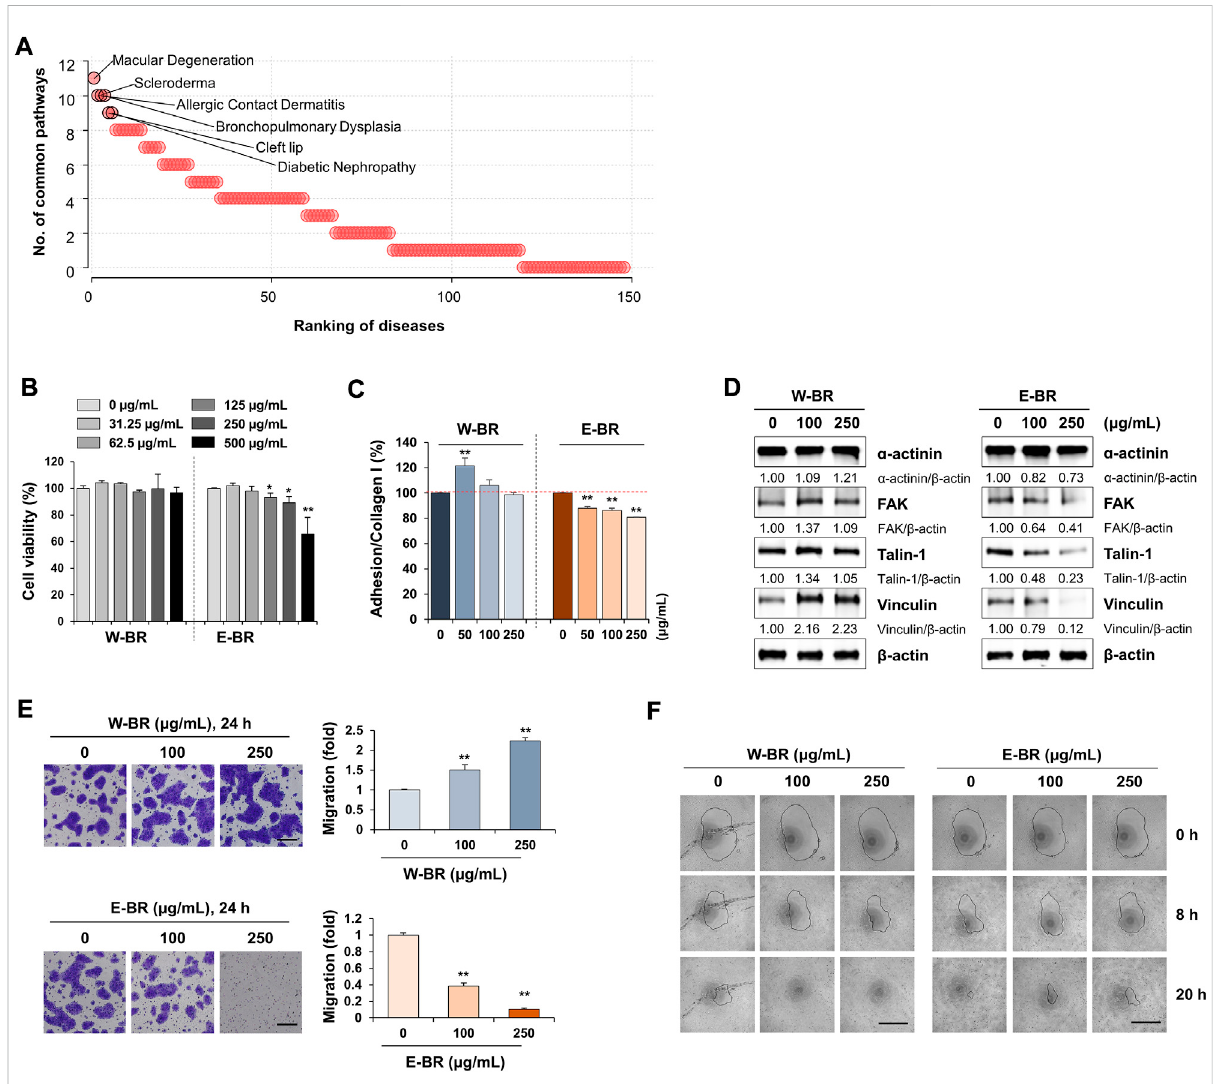
FIGURE 4 Effectsofbupleuriradixwaterextract(W-BR)andbupleuriradixethanolextract(E-BR)onproliferation,adhesion,andmigrationofHaCaTcells. (A) Prediction of indications of W-BR. The ranking of diseases associated with W-BR was measured as the number of common pathways that were signi fi cantly enrichedinexpressionsignaturesofdiseaseandW-BR. (B) HaCaTcellsweretreatedwiththeindicatedconcentrationsofW-BRorE-BR for24h,andthencellviabilitywasmeasured. (C) HaCaTcellstreatedwithorwithoutW-BRandE-BRwereaddedontocollagenI-coatedwells. After incubating cells for 30 min, attached cells were quantitated. (D) The levels of ɑ -actinin, focal adhesion kinase, talin-1, and vinculin were detected by immunoblotting in W-BR or E-BR-treated HaCaT cells. Relative band intensities were calculated after normalization to β -actin expression. Data are representative of two independent experiments. (E) HaCaT cells were pretreated with W-BR or E-BR for 24 h and evaluated